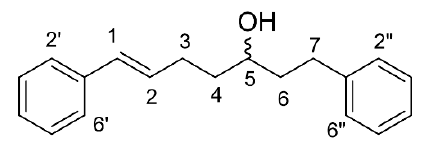
Figure 2. The chemical structure of compound 2 ( trans -1,7-diphenyl-5-hydroxy-1-heptene).